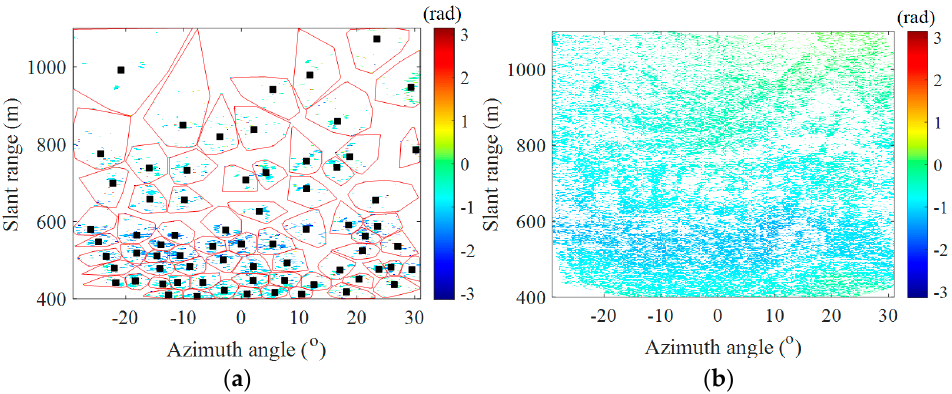
Figure 12. ( a ) Cluster division map; ( b ) estimated phase map of the pixels belonging to CS QPS . After compensating the spatial phase components, the TPC of those pixels belonging to CS QPS is calculated based on (6), as shown in Figure 13a. According to the analysis conclusion in Section 2.2, a TPC threshold of γ T = 0.91 equivalent to the ADI threshold of D T = 0.25 is set. A total number of 20,364 QPSs can be selected, as shown in Figure 13b. Contrast with the PS number, the QPS number occupies about 79.6%. Pixels with the TPC γ TPC lower than the threshold γ T = 0.91 belong to the set CS DS . Figure 13c shows the probability density curves of γ TPC of the reference PSs and CS QPS . The shapes of both curves are much different. This illuminates that with a lower ADI threshold, pixels with high amplitude stability are more possible to be also with high phase stability. Figure 13d shows the scatter map of γ TPC with D A for the reference PSs and CS QPS . Its distribution trend is much similar with the simulation results shown in Figure 3a. The PS